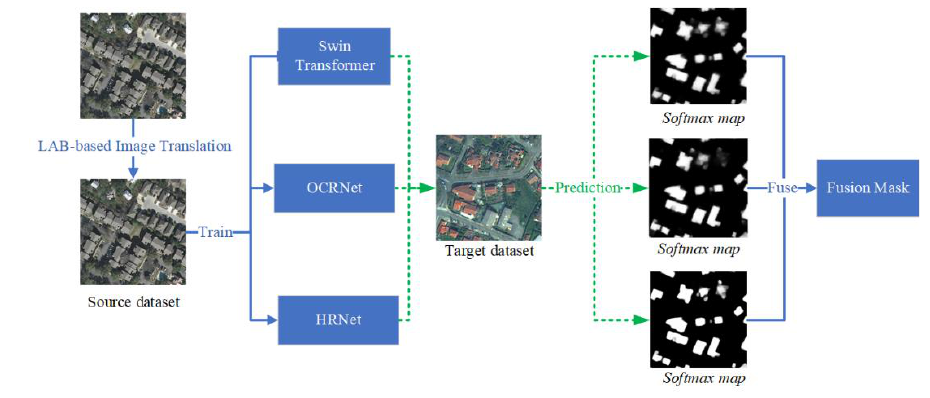
Figure 1 . Flowchart of the proposed method